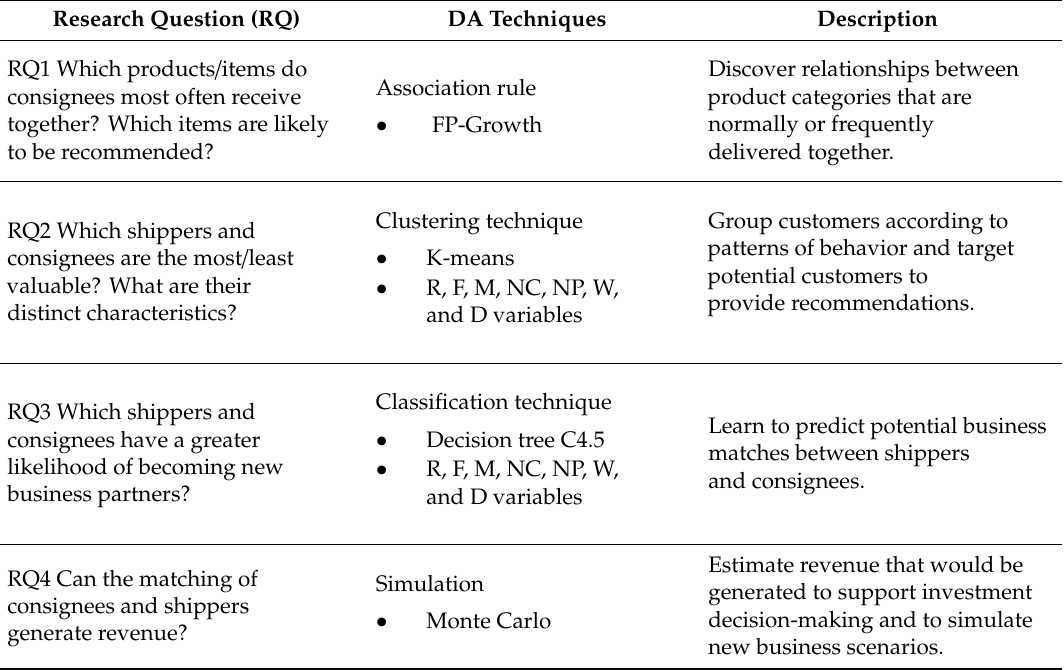
Table 1. Summary of research questions and selected techniques from the literature review.